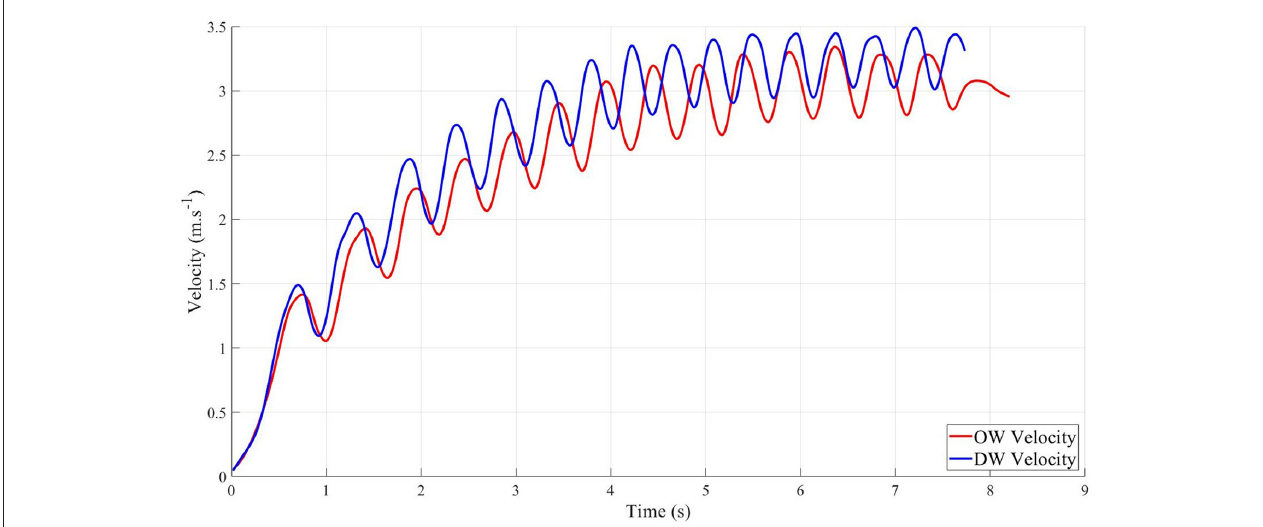
FIGURE 4 | Example of velocity curves of offensive wheelchair (OW) and defensive wheelchair developed by typical participant during 20m sprint.